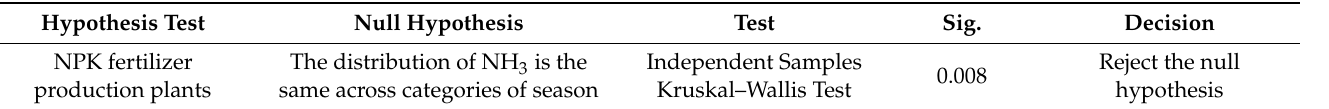
Table 5. The result of the Kruskal–Wallis test by NH 3 concentration at NPK fertilizer production plants.